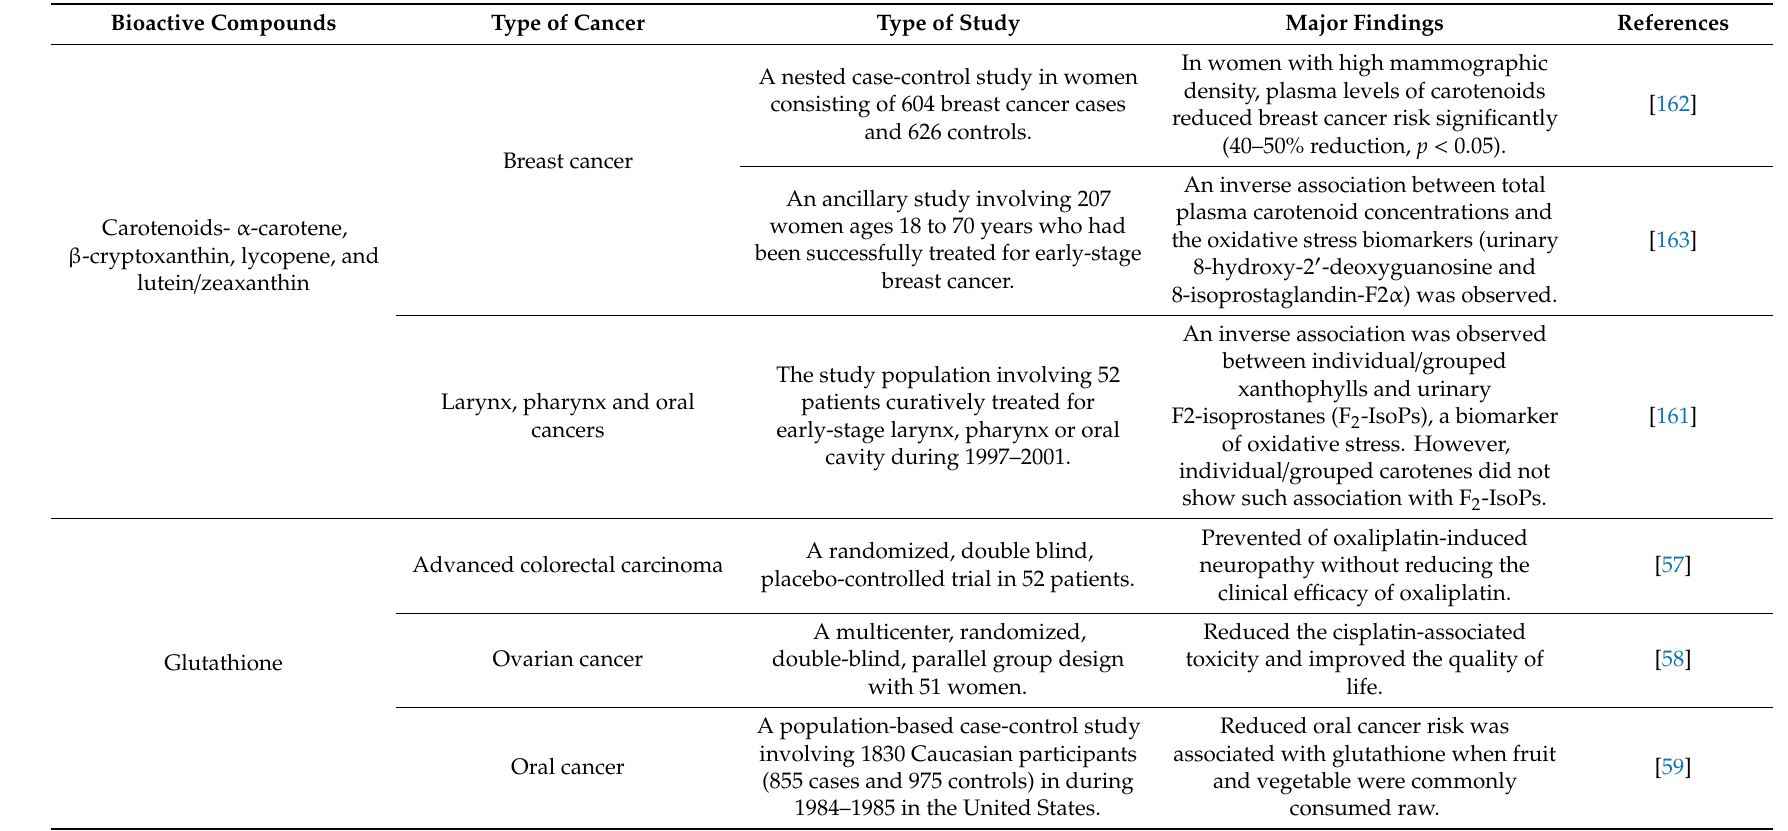
Table 5. Clinical studies demonstrating the anticancer activity of bioactive compounds that are also commonly found in Persea americana